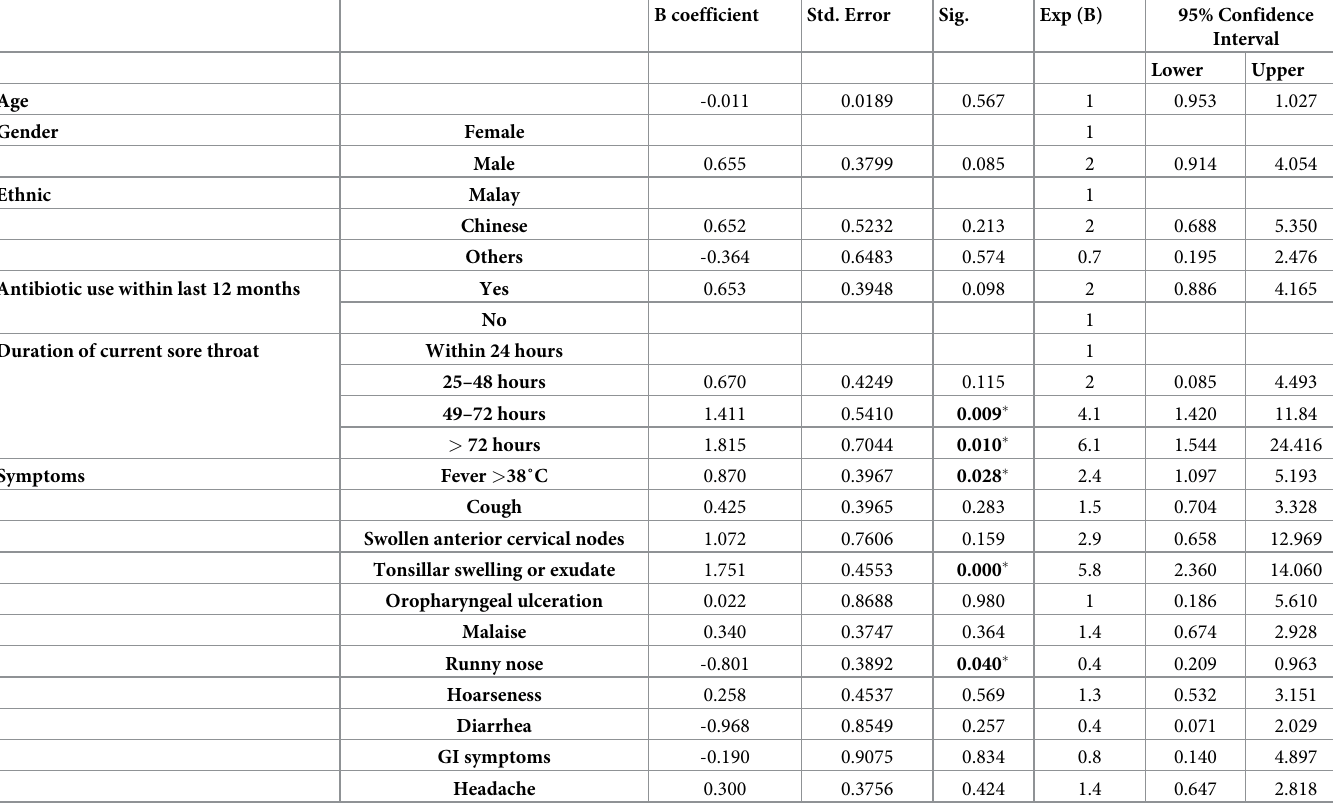
Table 8. Risk factors associated with antibiotic prescription using Generalized Estimating Equation Logit